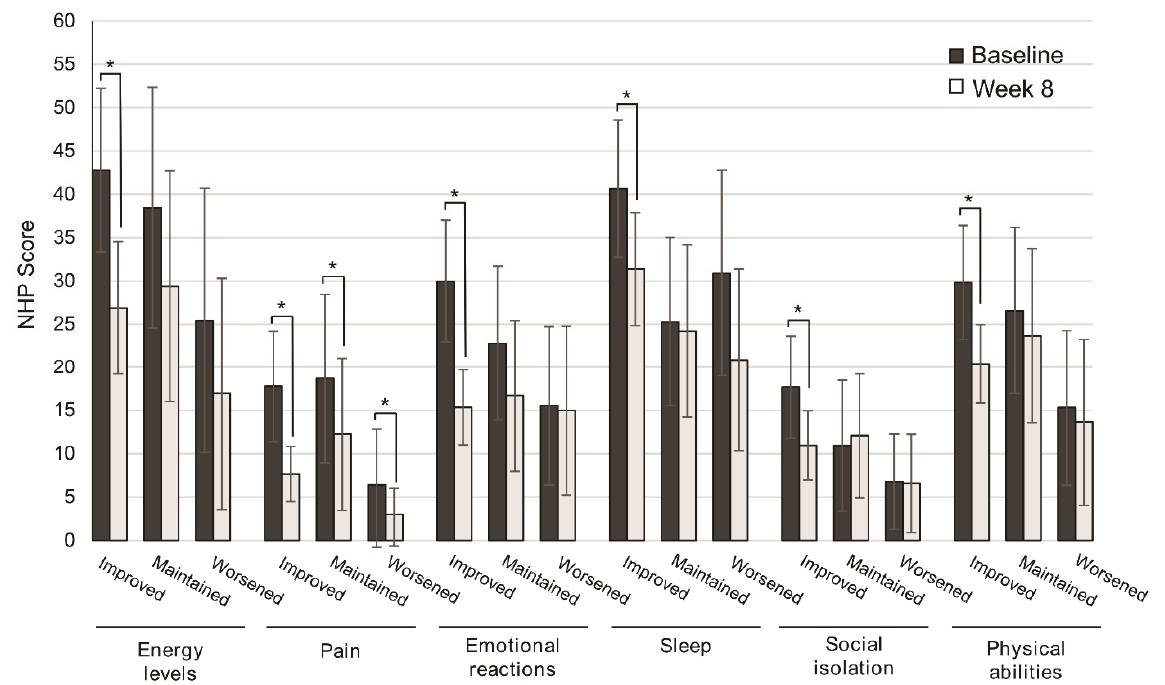
Figure 4. Change in quality of life after 8 weeks of oligomeric enteral nutrition (OEN) by the consistency of stool evolution. The bars show mean scores ± 95% CI for each category of the Nottingham Health Profile at baseline and after 8 weeks of OEN treatment for patients who improved, maintained, or worsened the consistency of stools with the OEN protocol. * indicates p < 0.05 (from baseline to week 8). The NHP score ranges from 0 (does not perceive any health problem) to 100 (maximum health problems perceived by the patient).